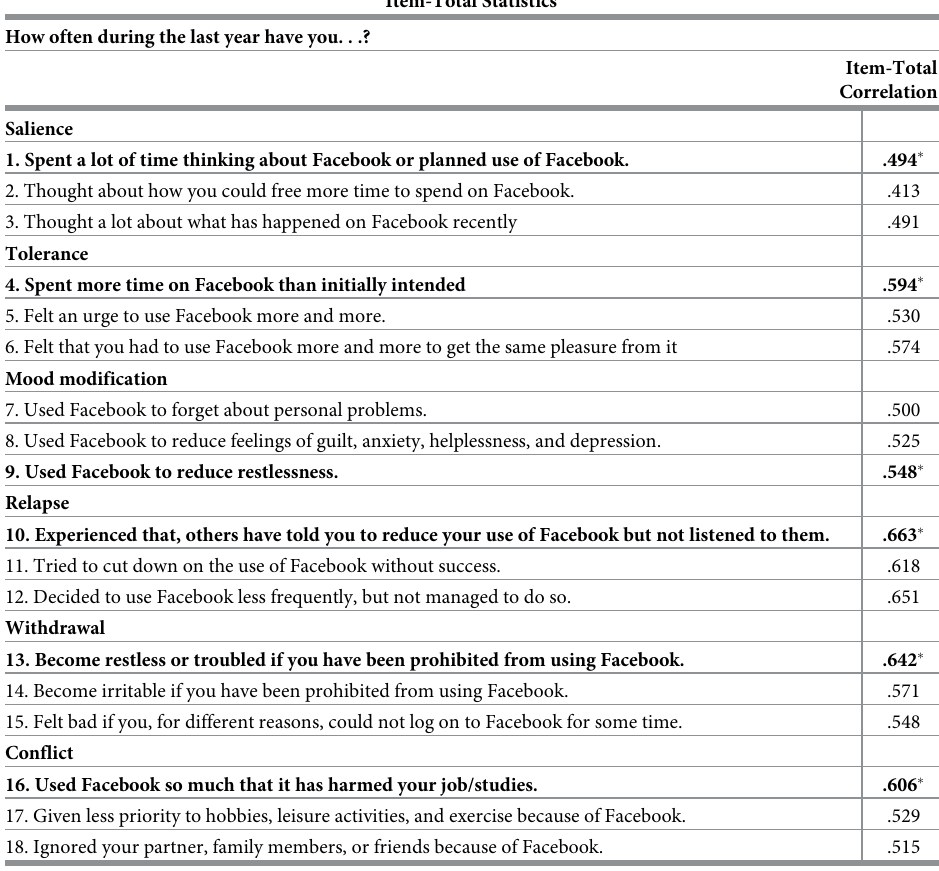
Table 1. The Bergen Facebook Addiction Scale: Items and inter-correlations of ratings. Item-Total